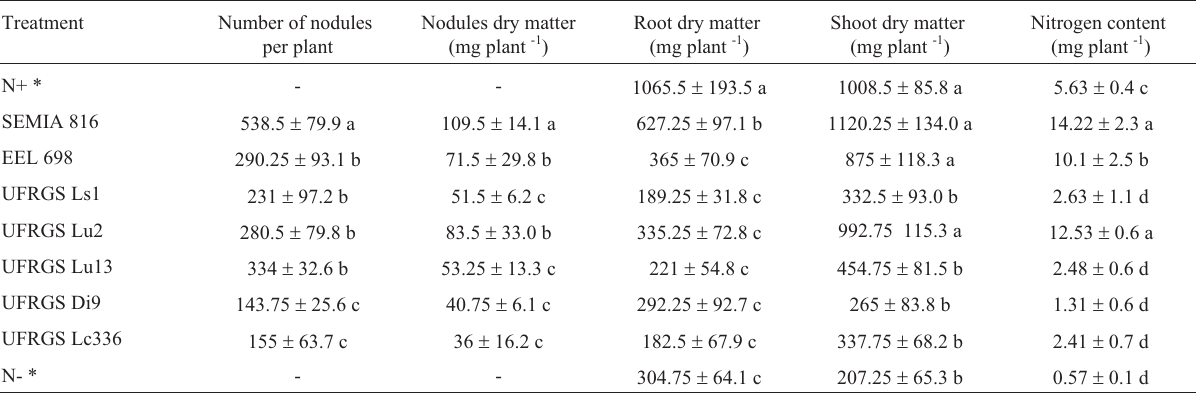
Table4 -Greenhouseexperimentwiththeinoculationof L.corniculatus plantswithrhizobialisolatesorreferencestrainsthatareabletonodulateboth L. corniculatus and D. incanum plants. Treatment